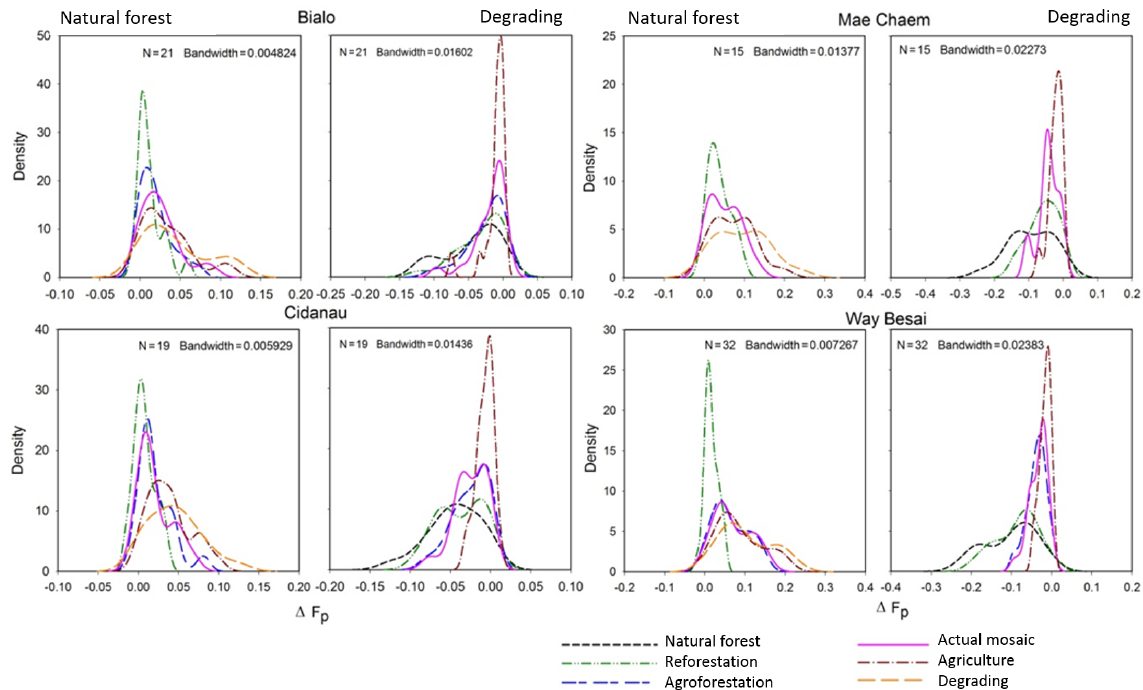
Figure 6. Frequency distribution of expected difference in F p in “paired-plot” comparisons where land cover is the only variable; left panels: all scenarios compared to “reforestation”; right panel: all scenarios compared to degradation; graphs are based on a kernel density estimation (smoothing) approach.